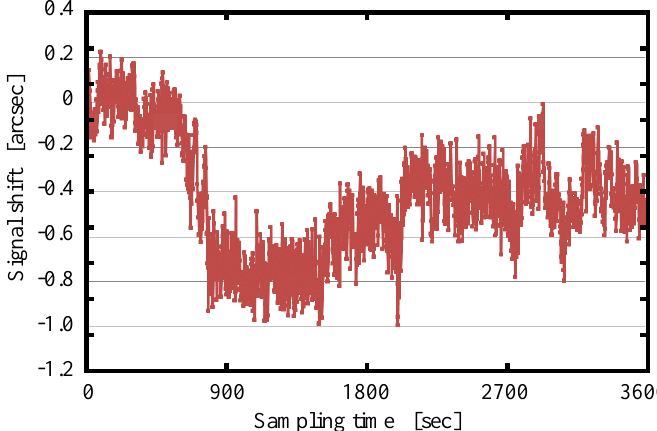
Figure 14. Stability of output signals of the autocollimator (AC2) in the wavelength corrector kit.